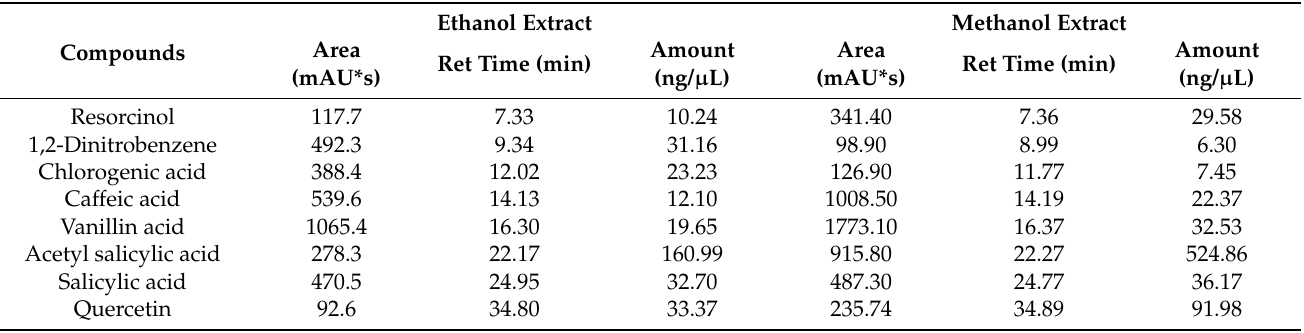
Table 3. Phenolic and flavonoid compounds of Tribulus Terrestris (TT). The phenolic compounds were analyzed via HPLC in